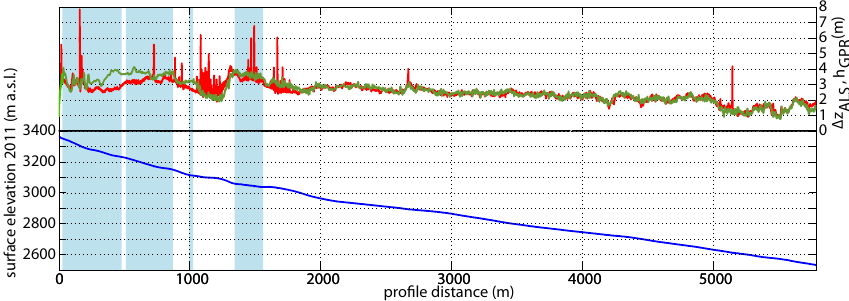
Fig. 11. Elevation of the surface in fall 2011 (blue curve), ALS surface elevation change 1z ALS (red curve) and GPR snow depth h GPR (green curve) along the longitudinal profile H1 at Hintereisferner. Snow covered areas derived from Landsat image of 31 August 2009 (LSC) are shaded in